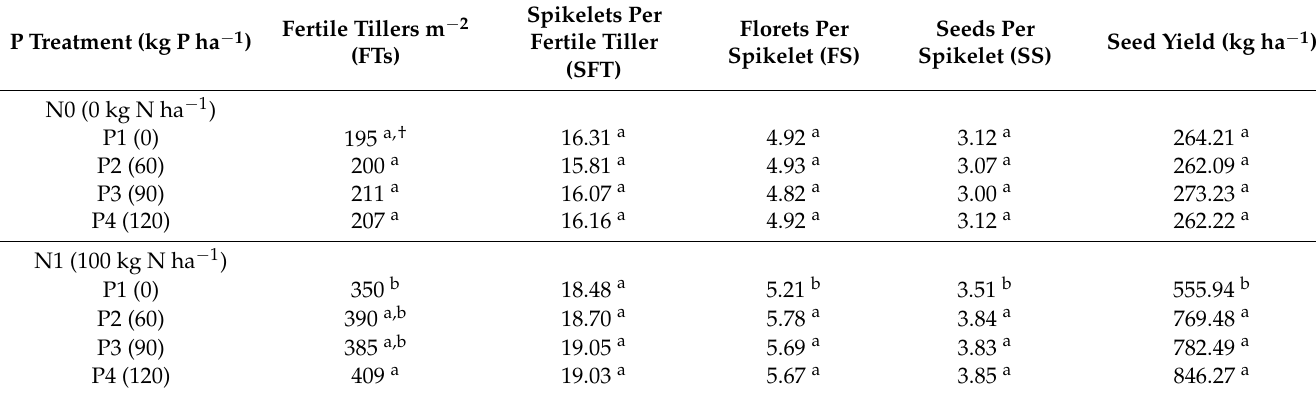
Table 3. Effects of P application on seed yields and seed yield components in smooth bromegrass under certain N application levels